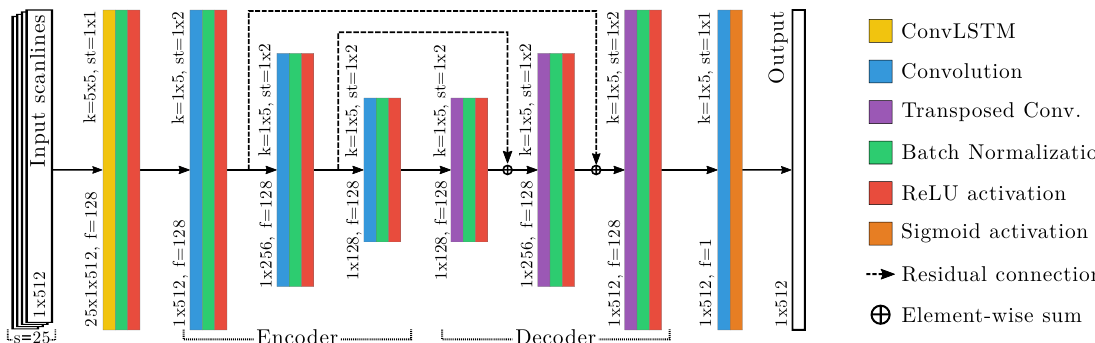
Figure 4. Scheme of the CMSAE network specialized for the segmentation of oil spills. In this figure, the layer type is labeled with colors according to the side legend. The size of each layer for convolutions and transposed convolutions is h × w , where h is the height and w the width. The size for the ConvLSTM layer is s × h × w , where s is the sequence length. The number of filters ( f ), the kernel size ( k ) and the stride value ( st ) applied for each layer are also shown. The CMSAE networks used for the segmentation of the other classes follow the same scheme, although their topologies